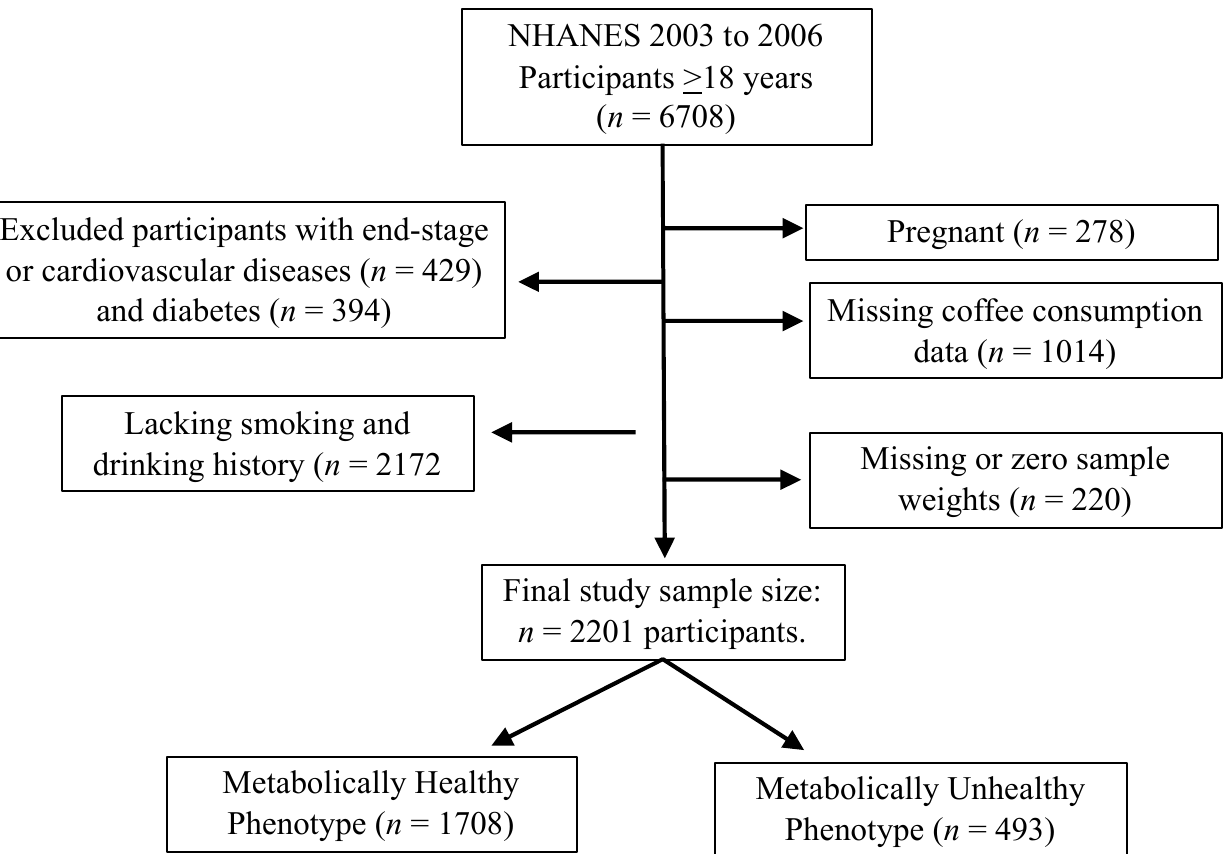
Figure 1. Study participant selection criteria, NHANES 2003 to 2006.